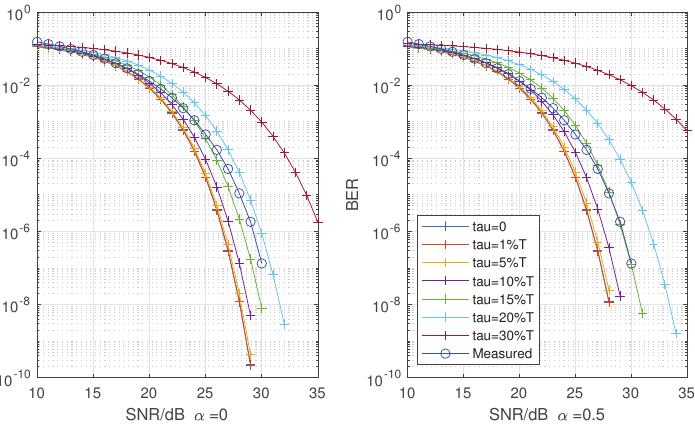
Figure 14. Measured BER of 64 QAM and theoretical at roll-off α = 0 ( left ) and α = 0.5 ( right ) with RC. The measured values in Figures 13 and 14 are a statistical result of multiple